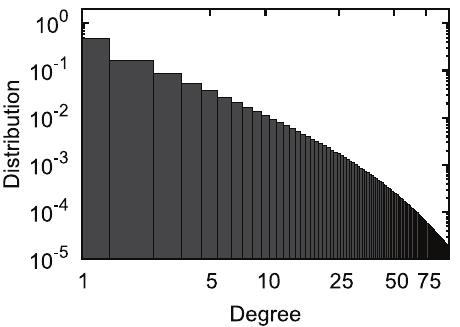
Figure 9. The fat-tailed degree distribution (contact per individual) with power-law tail and exponential cut-off. Used to generate heterogeneous networks for the MC simulations.